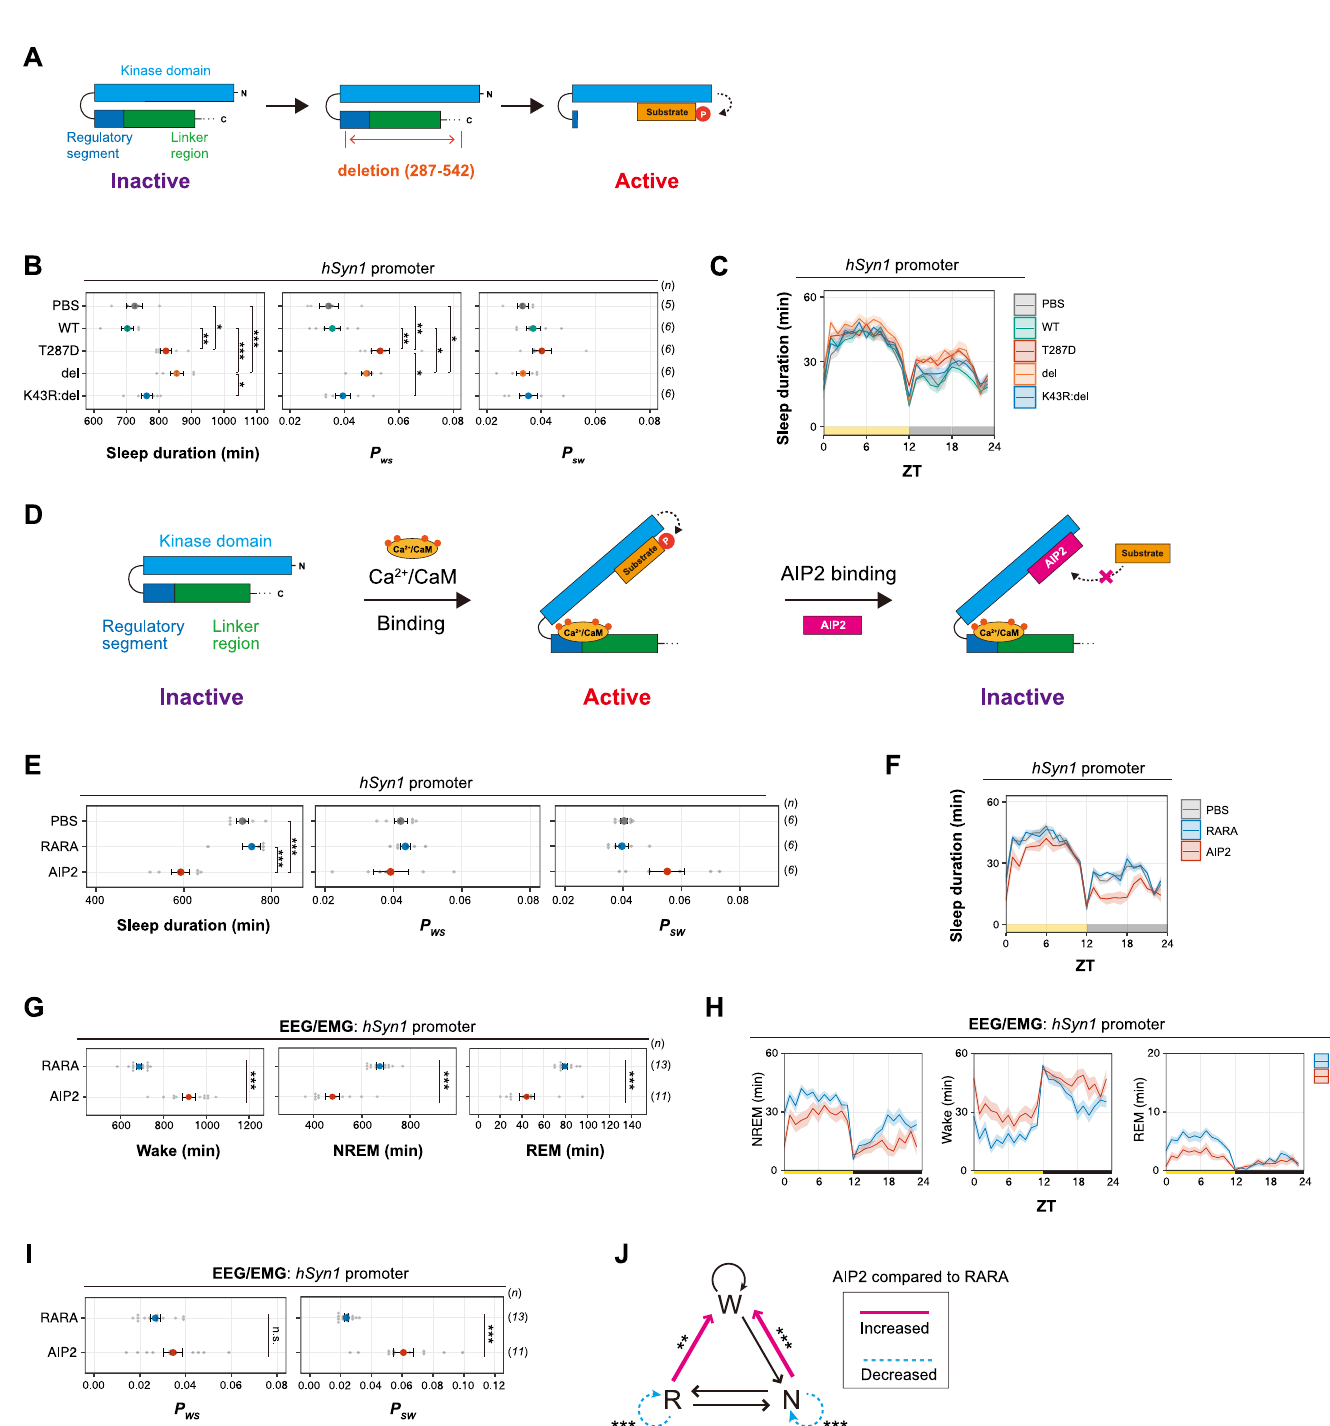
Fig 2. Perturbation on the kinase activity of CaMKII affects sleep duration. (A) Schematic diagram of CaMKII β activation via deletion of its C-terminus. Deletion of the regulatory segment and linker region exposes the kinase domain of the CaMKII β and makes the enzyme constitutively activated. (B, C) Sleep/wake parameters (B) and sleep profiles (C) of mice expressing the CaMKII β del mutant, averaged over 6 days. The shaded areas represent SEM. Multiple comparison tests were performed between all individual groups. (D) Schematic diagram of CaMKII inhibition by AIP2 expression. AIP2 competitively binds to the kinase domain and inhibits substrate phosphorylation. (E, F) Sleep/wake parameters (E) and sleep profiles (F) of mice expressing AIP2 or the RARA mutant measured by the SSS, averaged over 6 days. PBS: PBS-injected mice ( n = 6). (G-I) Sleep phenotypes (G and I) and sleep profiles (H) of mice expressing AIP2 or the RARA mutant measured by EEG/EMG recordings. (J) Differences in transition probabilities (between wakefulness (W), NREM sleep (N), and REM sleep (R)) between mice expressing AIP2 or the RARA mutant. Magenta lines and dashed blue lines indicate when the values for the AIP2-expressing mice are significantly ( p < 0.05) higher and lower, respectively. The underlying data can be